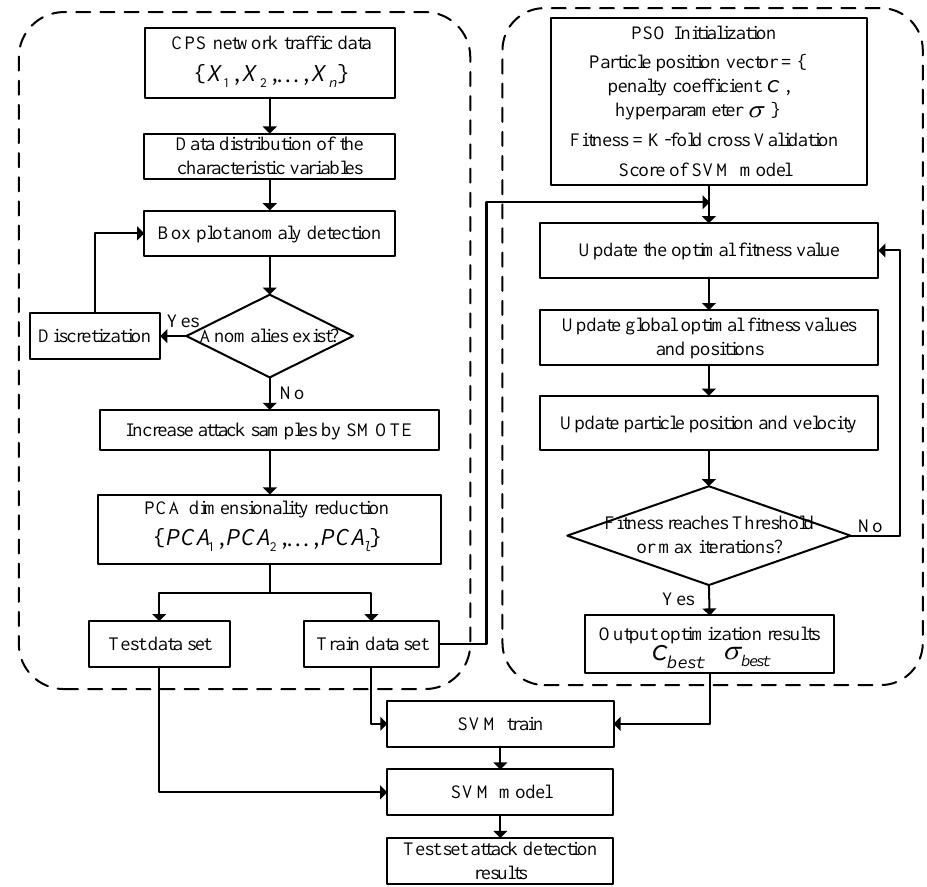
Figure 2. CPS attack detection flow chart.